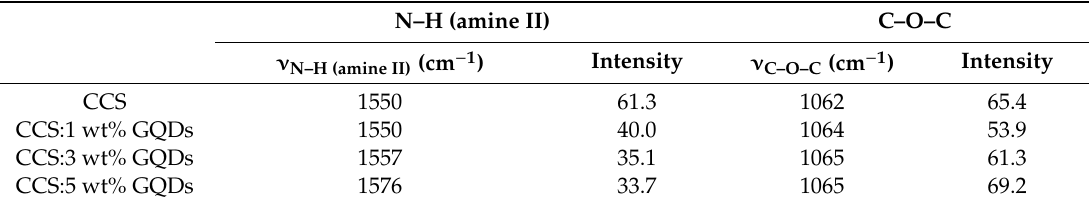
Table 2. Evaluation of the percent deacetylation based on FTIR spectra of pure CCS and CCS:GQDs